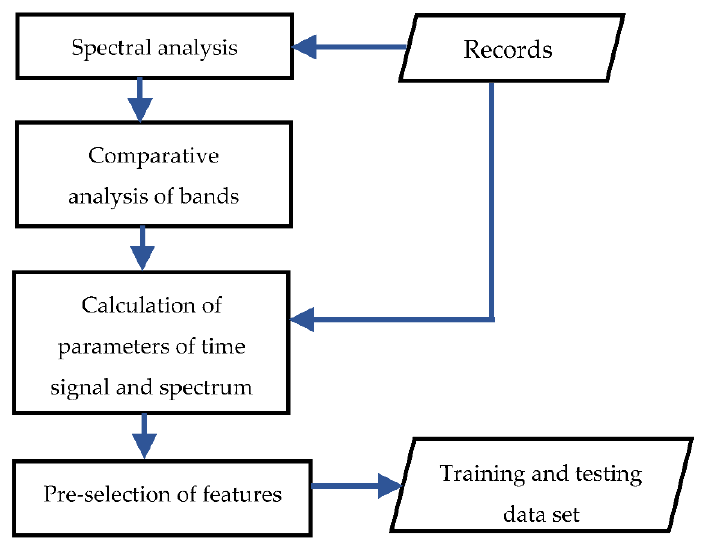
Figure 12. The algorithm for processing the registrations of vibration signals.